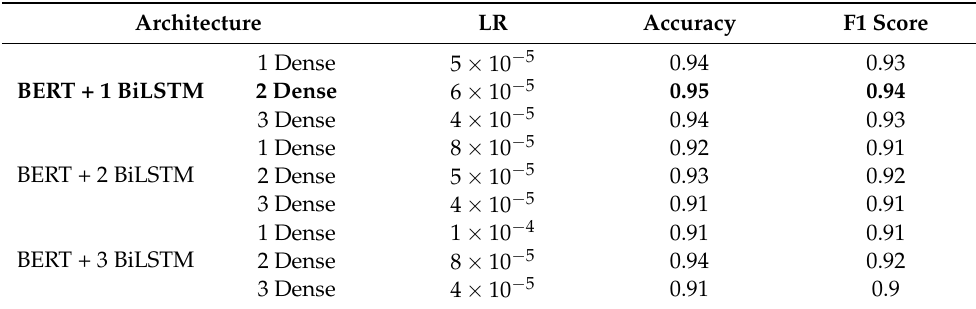
Table 4. Comparing BERT + BiLSTM Classifier results. (Bold text indicates the model parameters achieving the highest